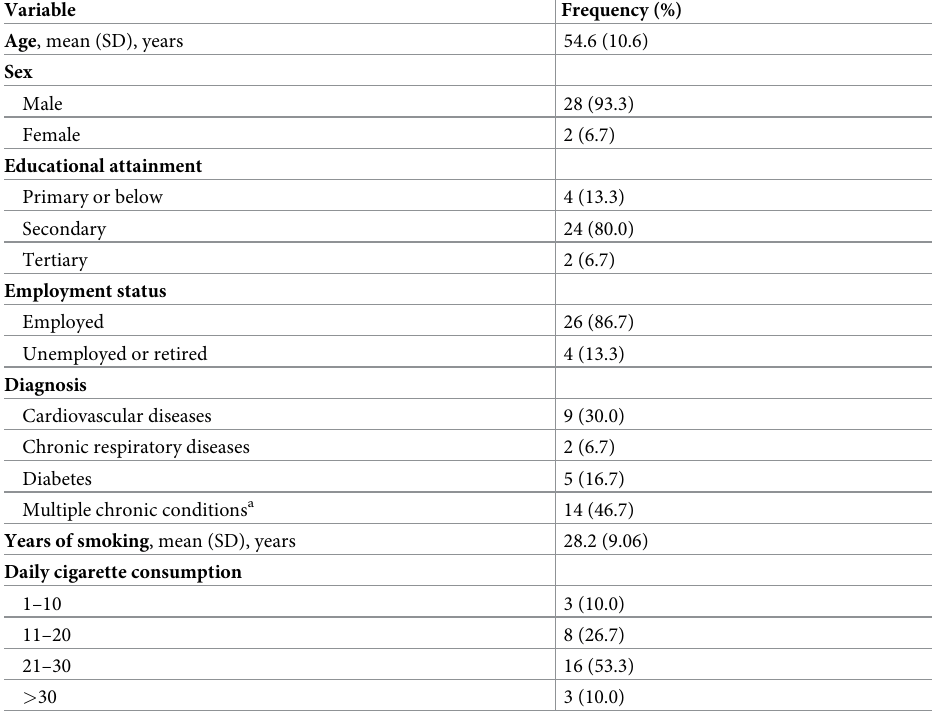
Table 1. Baseline characteristics (N =